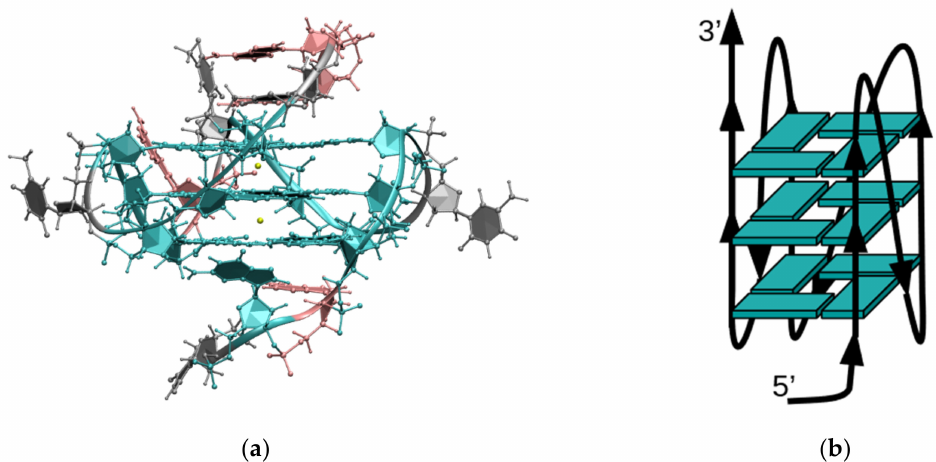
Figure 12. ( a ) Ball and stick representation of the 20th set of coordinates of 1XAV, representing the residues with the following color code: cyan, guanine; pink, adenine; gray, thymine; yellow, potassium. ( b ) Schematic representation of the full parallel-type monomolecular